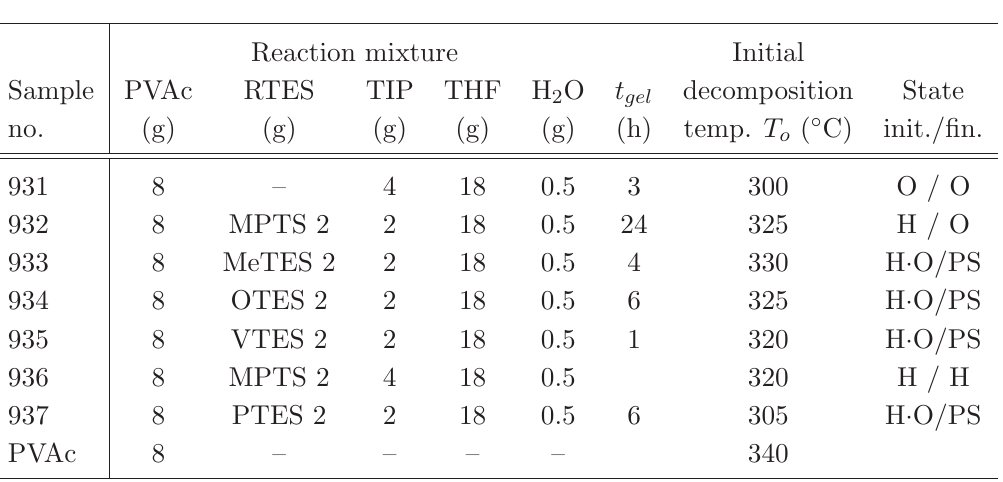
Table 2 Conditions of hybrids with PVAc and